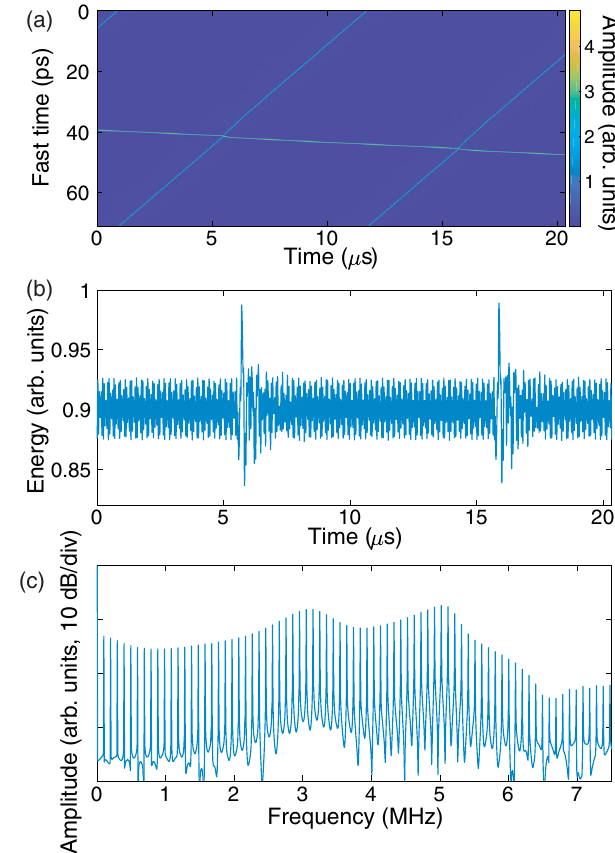
FIG. 9. Simulation of soliton collision. (a) Intracavity field amplitude evolution showing two collision events. (b) The corresponding intracavity energy evolution. (c) The calculated spectrum of the intracavity energy